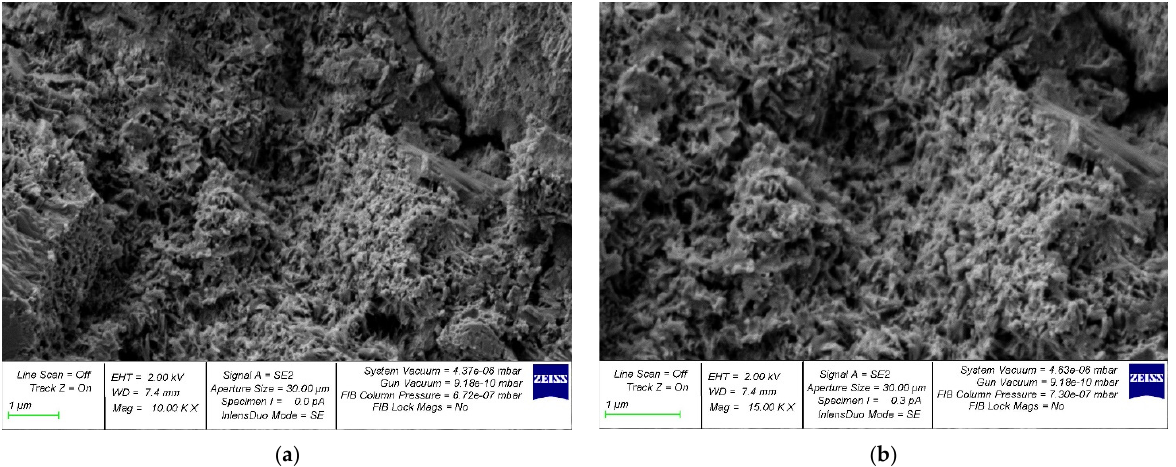
Figure 7. Samples with a nanosilica content of 4% by weight of cement with an increase: ( a ) 10,000× and ( b ) 15,000×.